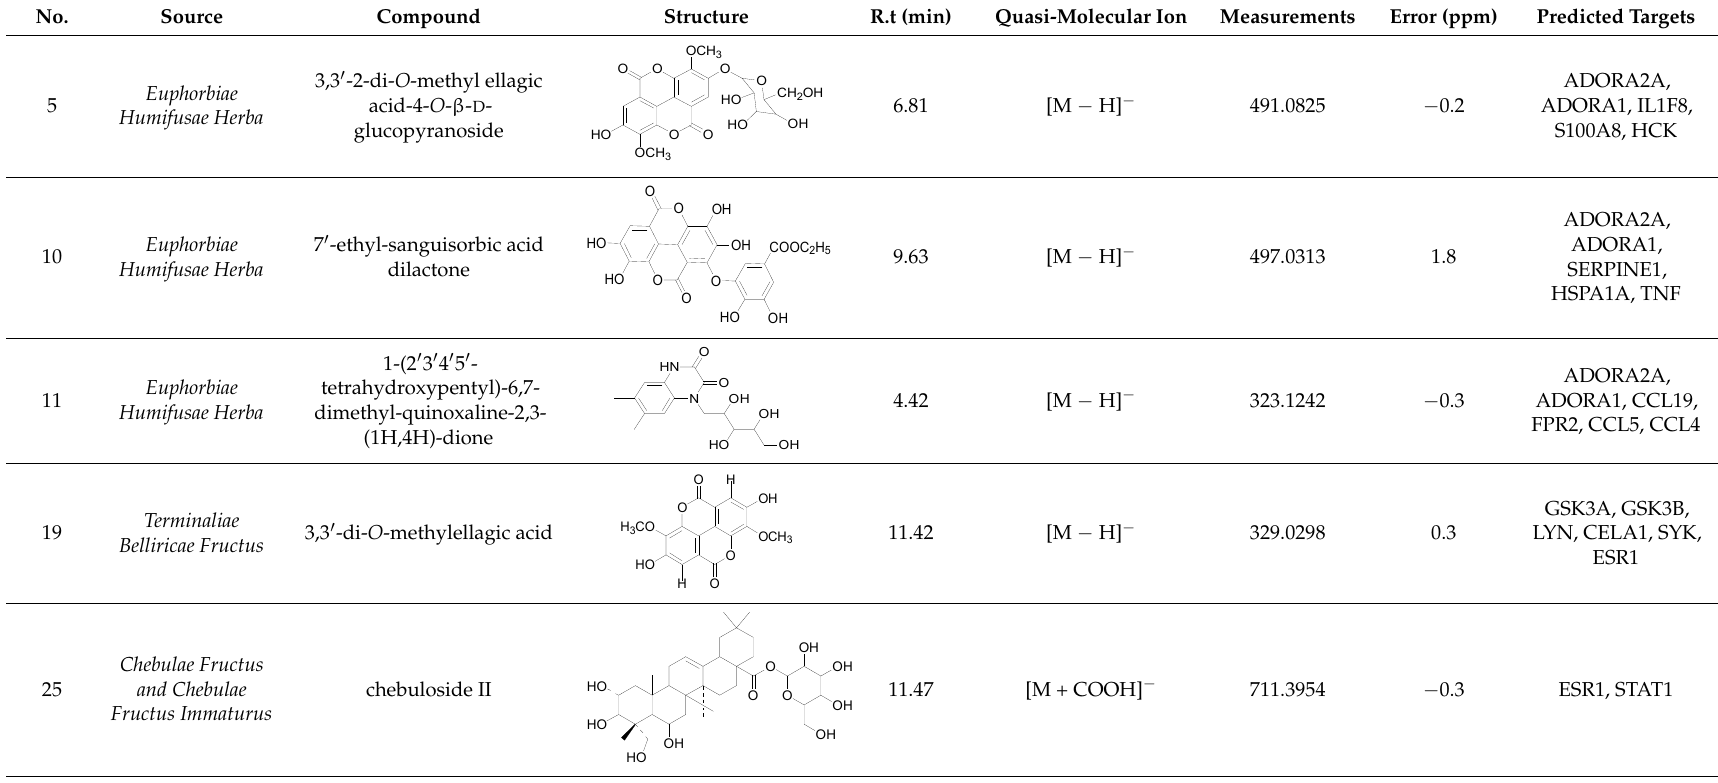
Table 1. Potential anti-inflammatory constituents by target prediction.